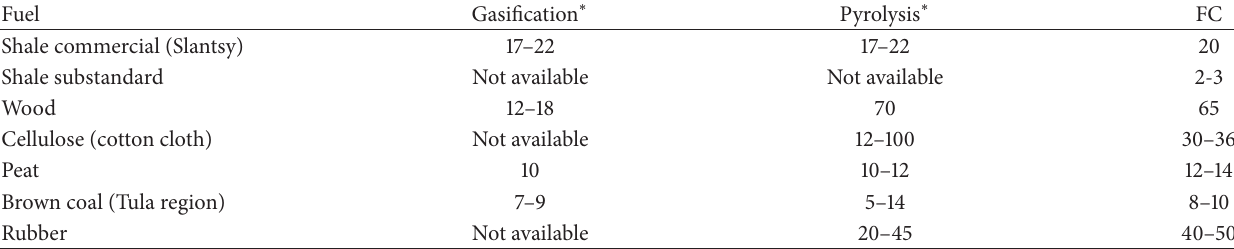
Table 1: The yield of tars formed from different materials at the thermal processing, %.